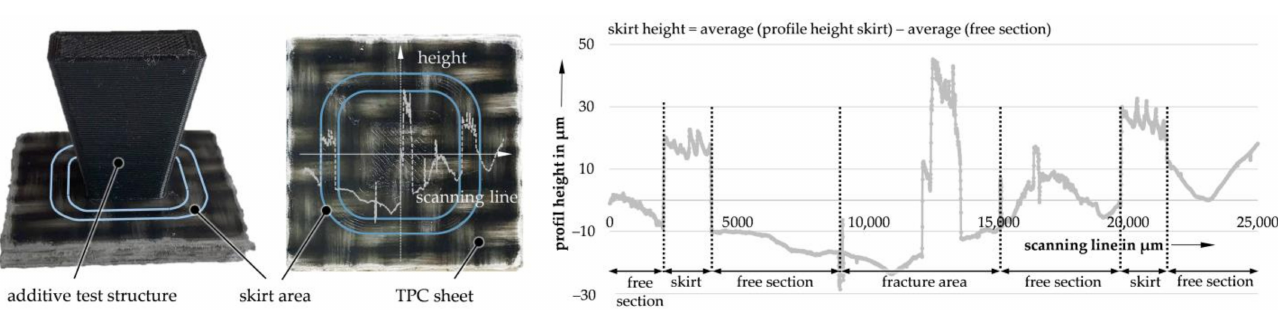
Figure 1. Profilometer measurement and calculation of FLM nozzle distance via skirt